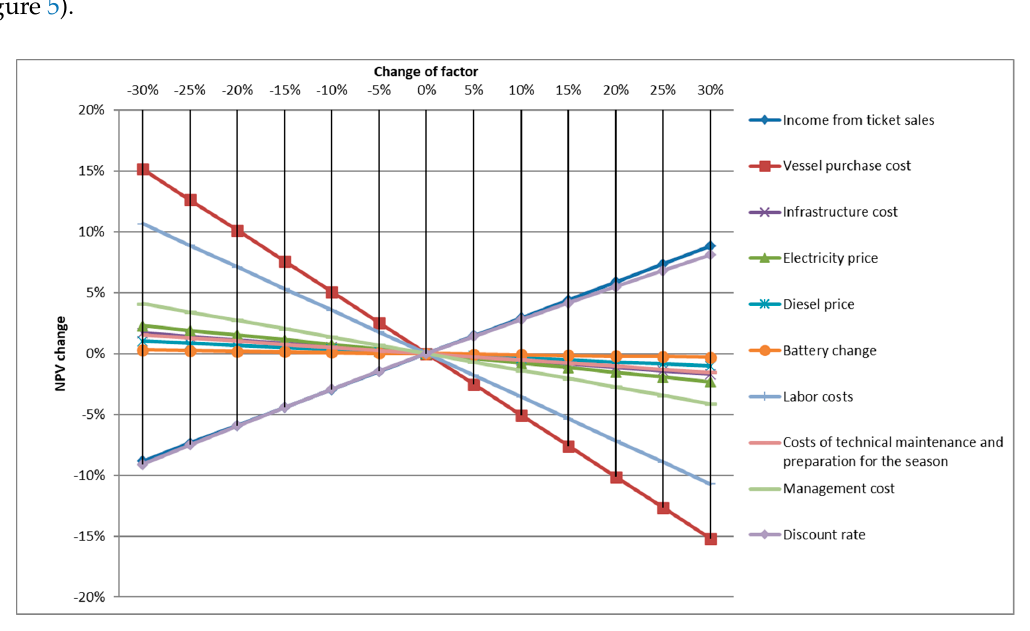
Figure 5. The NPV sensitivity to changes in the main economic factors.